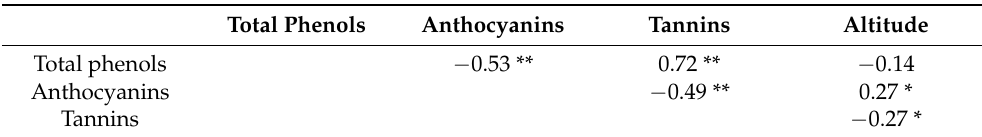
Table 3. Correlation among total phenols, anthocyanins and tannins content and altitude using a Pearson’s correlation. ** p < 0.05, * p < 0.01.